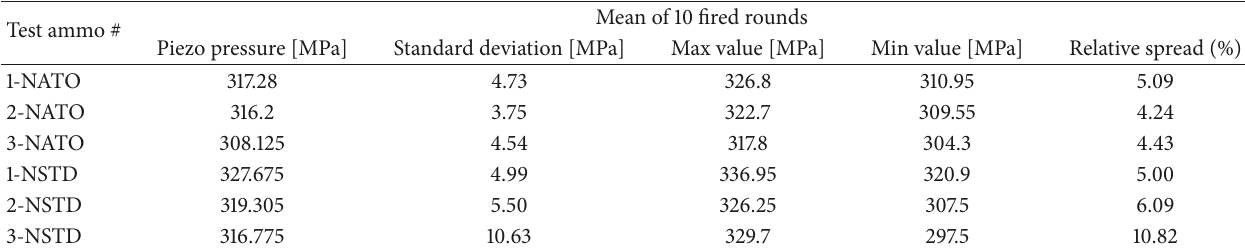
Table 5: Standard deviation and relative spread using piezo pressure method at 25